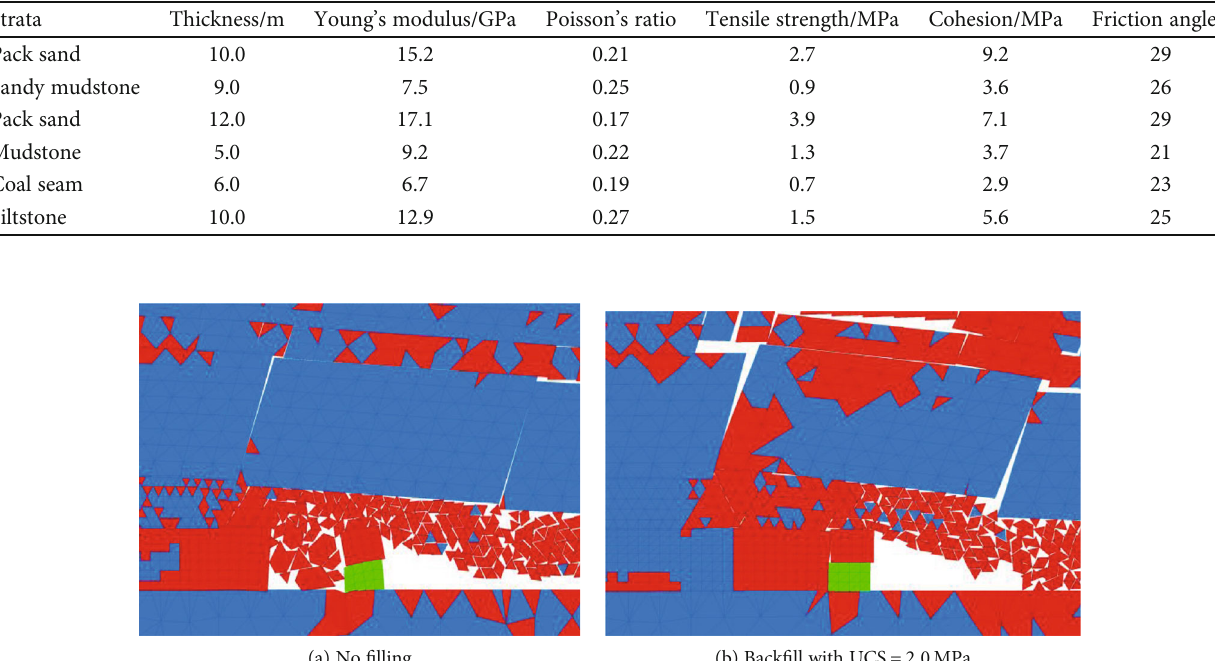
Table 1: Material parameters in the numerical